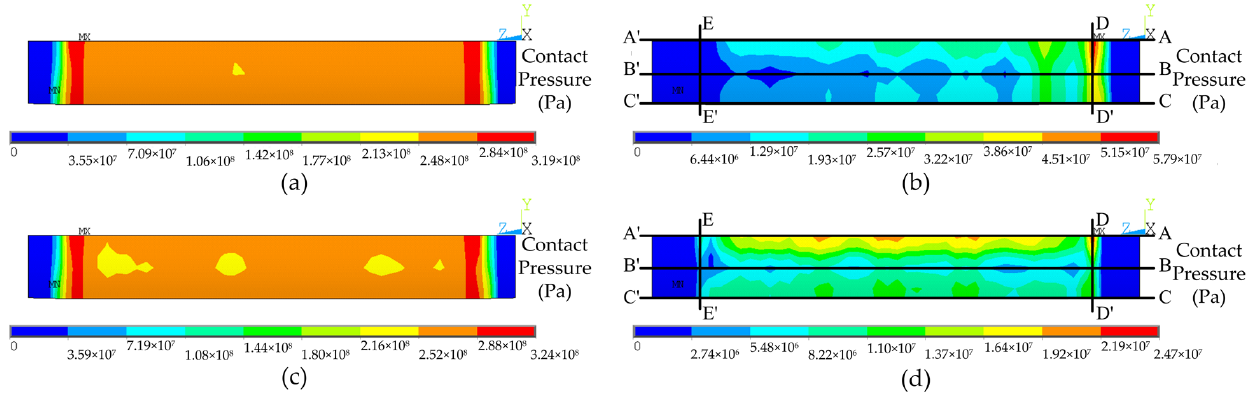
Figure 6. Contact pressure distribution on the contact surface of two kinds of tubesheets: ( a ) TA2 - Q345R clad tubesheet after loading; ( b ) TA2 - Q345R clad tubesheet after unloading; ( c ) Q345R tubesheet after loading; ( d ) Q345R tubesheet after unloading .